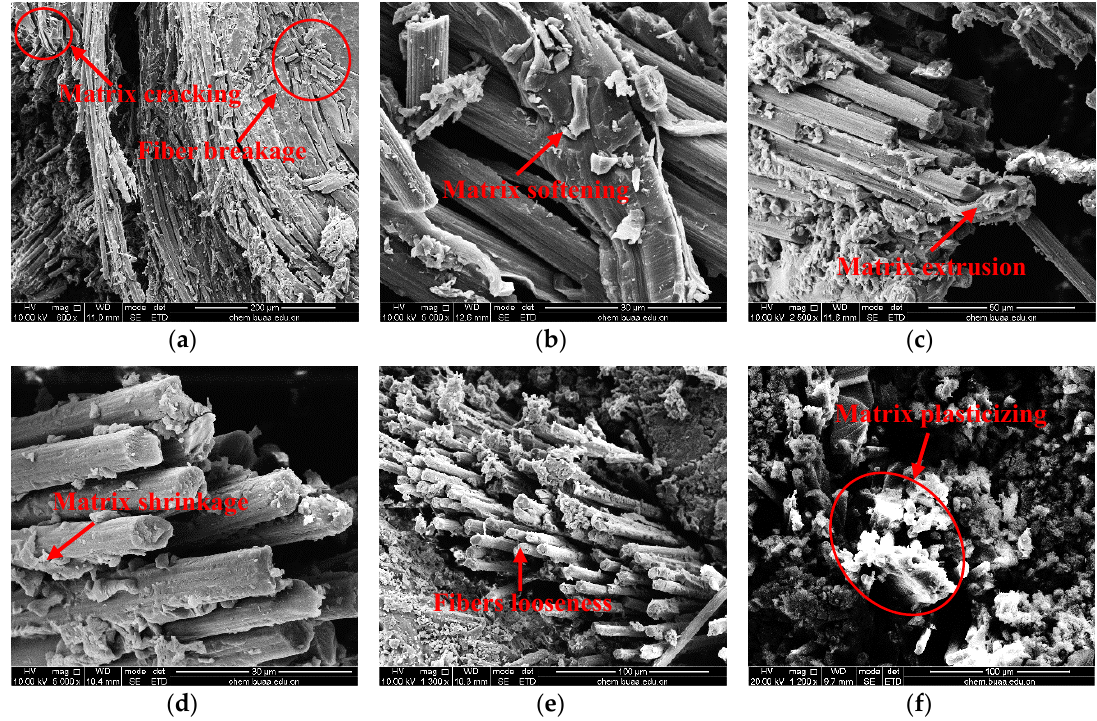
Figure 10. SEM photographs of specimens with 32° braiding angle at different temperatures: ( a ) 25 °C, ( b ) 60 °C, ( c ) 90 °C, ( d ) 120 °C, ( e ) 150 °C, and ( f ) 180 °C.